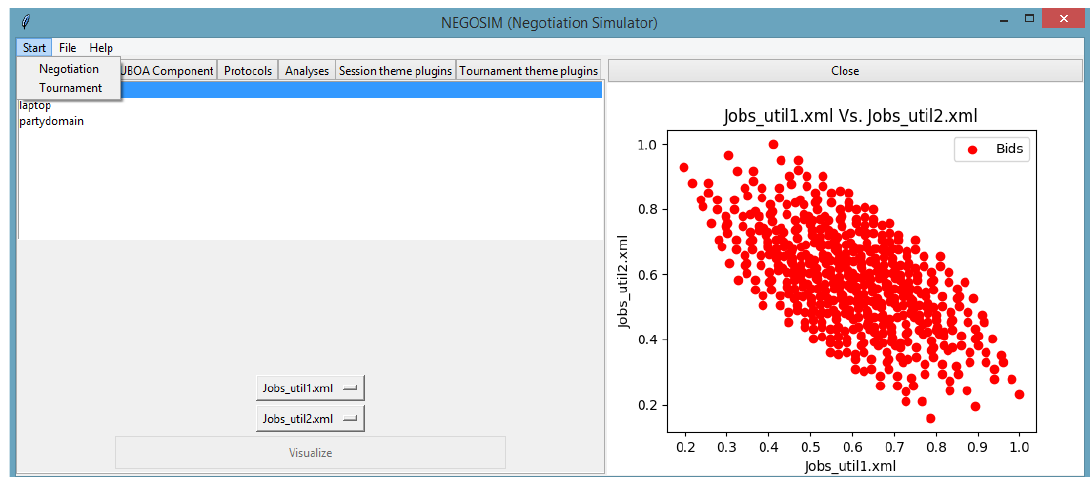
Figure 4. The basic GUI provides information about NegoSim components and entities.